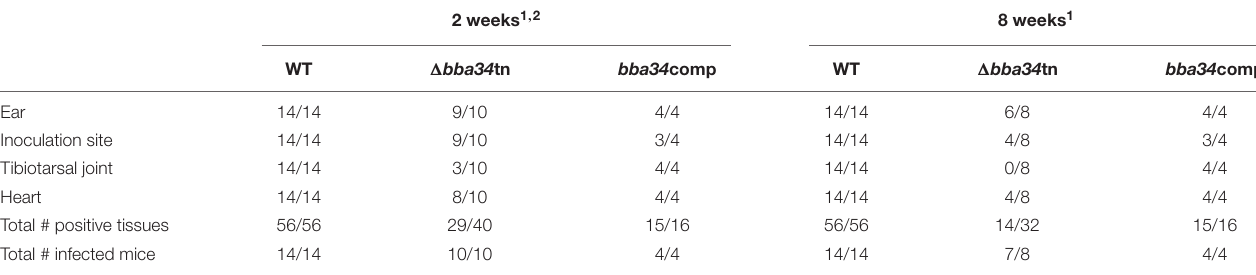
TABLE 5 | BBA34/OppA5 is required for persistence in